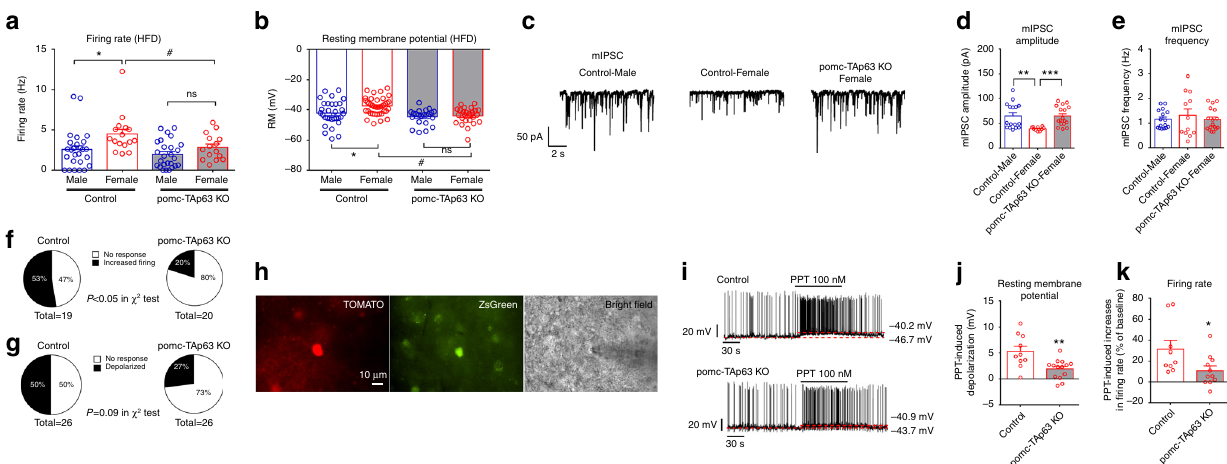
Fig. 6 Selective deletion of TAp63 in POMC neurons impairs neural activities of POMC neurons. a Firing rate, recorded by the whole-cell patch clamp, in POMC neurons from male and female mice, with or without POMC-speci fi c TAp63 deletion, that have been fed with HFD for 4 weeks. Data are presented as mean ± SEM with individual data points. N = 15 – 26 per group. * P < 0.05 between male and female with the same genotype; # P < 0.05 between the two genotypes with the same sex in two-way ANOVA followed by post hoc Sidak tests. b Resting membrane potential, recorded by the perforated patch